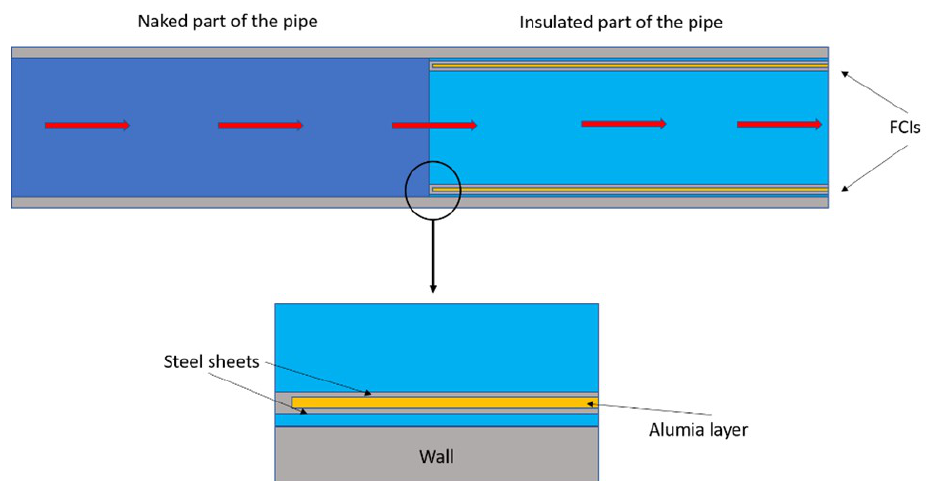
Figure 3. Sketch illustrating a Flow channel insert example configuration in a pipe (entrance in insulated region). Red arrows define metal liquid path. The FCI “sandwich” structure is highlighted in the